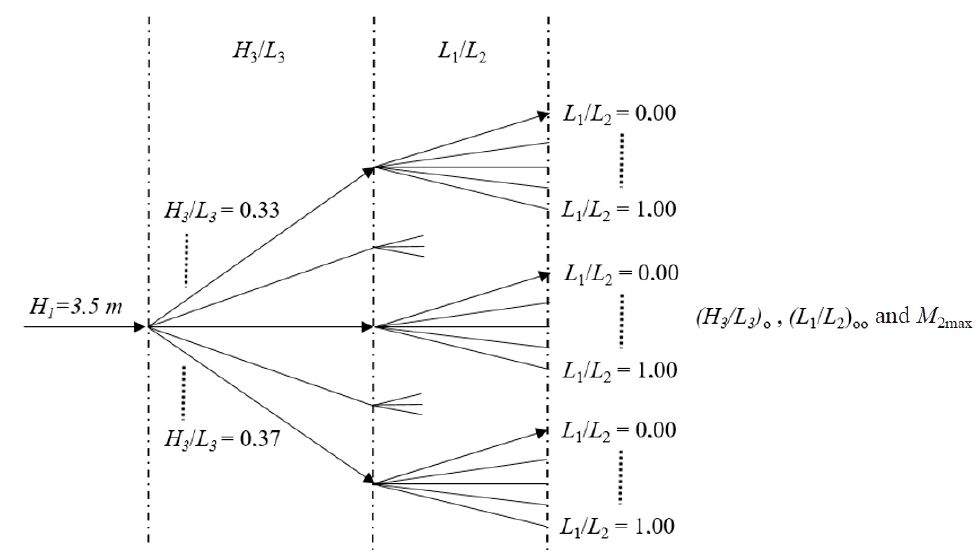
Figure 3. Illustration of the optimization process applied to the overtopping device varying two degrees of freedom.